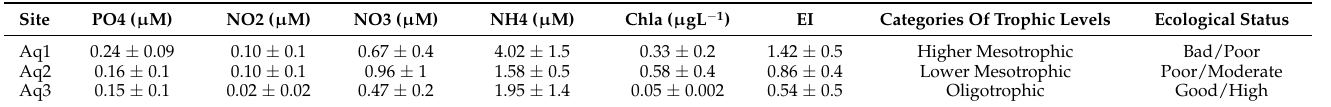
Table 1. Average concentrations of nutrient and chlorophyll a (Chla) for the three different aqua- culture sites. Calculation of EI and characterization of each fish farm. Data are expressed as the mean ± standard deviation.